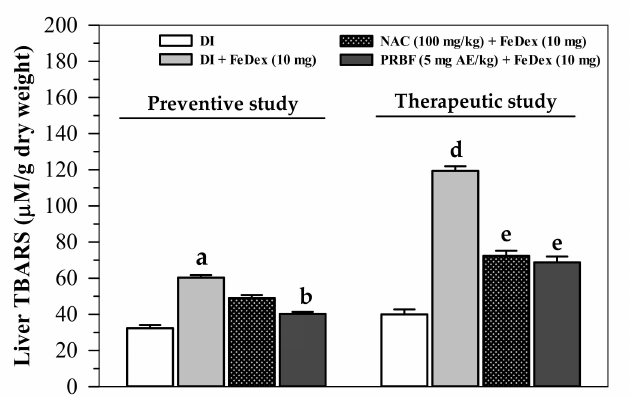
Figure 6. Levels of TBARS in the livers collected from FeDex-loaded mice that had been treated with DI, NAC and PRBF. In the preventive study, mice were treated with DI, NAC (100 mg/kg) and PRBF (5 mg AE/kg) for 14 d. This was followed by a single ip injection with 10 mg FeDex after the last oral dose was administered on day 14. Mice were then sacrificed; their internal organs were dissected and liver TBARS concentrations were determined. In the therapeutic study, mice were ip injected with 10 mg FeDex together with DI, NAC (100 mg/kg) and PRBF (5 mg AE/kg) for 14 d. Mice were then sacrificed, their internal organs were dissected and TBARS concentrations in the livers were determined. Data are expressed as mean ± SD values ( n = 6). a p < 0.05 when compared with DI alone in the preventive study and b p < 0.05 when compared with DI in FeDex- loaded mice; d p < 0.05 when compared with DI alone and e p < 0.05 when compared with DI